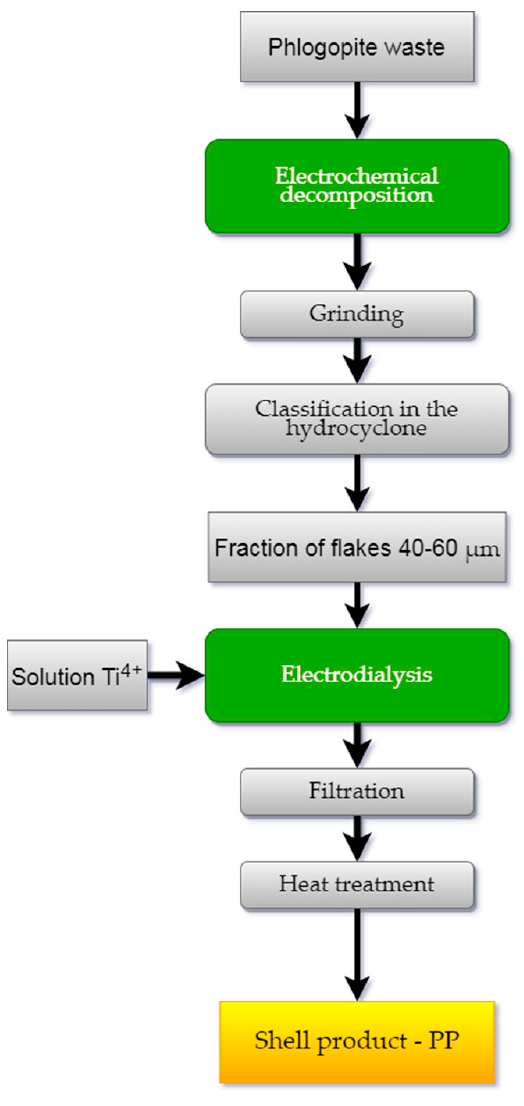
Figure 4. Electrochemical scheme of phlogopite waste processing. An electrochemical method was used to break down the mica particles. The choice of optimal conditions for the experiment is described in detail in [20,21]. Distilled water was used as a reagent. A mixture of the components with the mass ratio T:B = 10:5 (T—mica particles, B—water) was placed into an electrolyzer, in which a titanium plate served as a cathode and a graphite anode. The distance between the electrodes was 13 mm, the voltage across the electrodes was 220 V, the maximum current density was 0.2 A/cm 2 , and the duration of the experiment was 24 h. Then, wet grinding of the mica was carried out in the mill with a propeller stirrer equipped with cutting blades in the presence of a polymer bead filler. The number of the mixer revolutions was 800–900 rpm for 1.5–2 h [21,22]. The crushed material was subjected to classification with a separation of the working flakes of fraction 40–60 µ m